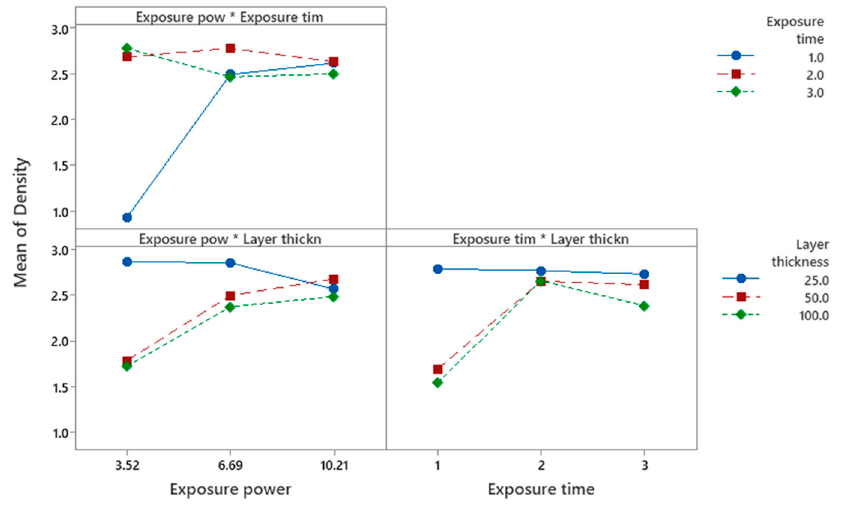
Figure 14. Effect of the process parameters interactions on the mean of the density.